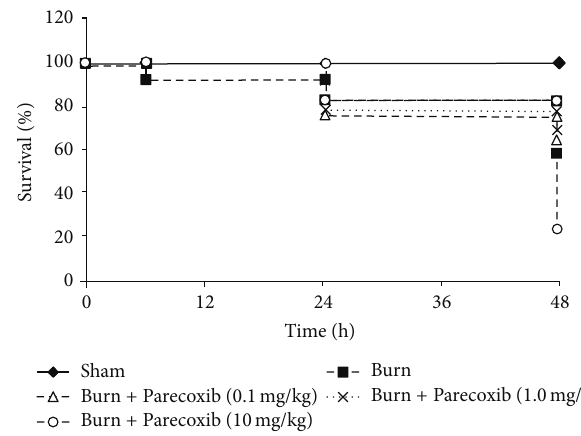
Figure 1: Effect of intramuscularly administered Parecoxib on survival rate of burned animals over 48h. Animals were divided into five groups of thirty animals per group. Animals in the burn groups were exposed to 98 ∘ C to 100 ∘ C water, scalding the back for 10 s and the abdomen for 4s. Hartmann’s solution (40 mL/kg) was administered i.p. half at 1h after burn and the remaining half at 8 h after burn. The burned animals were injected i.m. with saline, 0.1mg/kg, 1.0mg/kg, or 10 mg/kg Parecoxib at 20min, 12 h, 24 h, and 36 h after burn. Sham animals were exposed to 24 ∘ C water and similarly injected i.m. 10mg/kg Parecoxib as control. The survival rate of the animals was compared using Wilcoxon (Gehan) statistic.